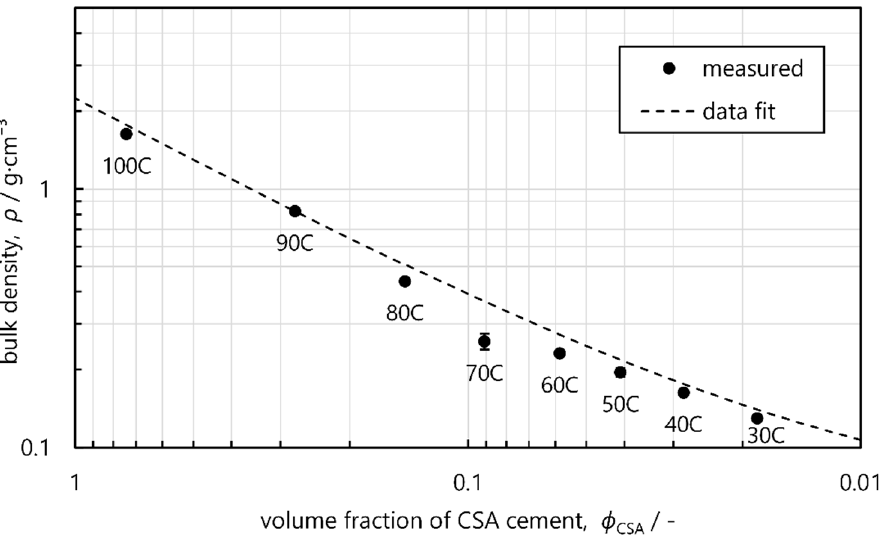
Figure 3. Calculated bulk density of each specimen based on Archimedes measurement. Data fit to f( ϕ ) = a 0 + a · ϕ v , with a 0 = 0.055, a = 2.184, and υ = 0.81. f( φ ) = a · φ v , with a 0 + a 0 = 0.055, a = 2.184, and υ =